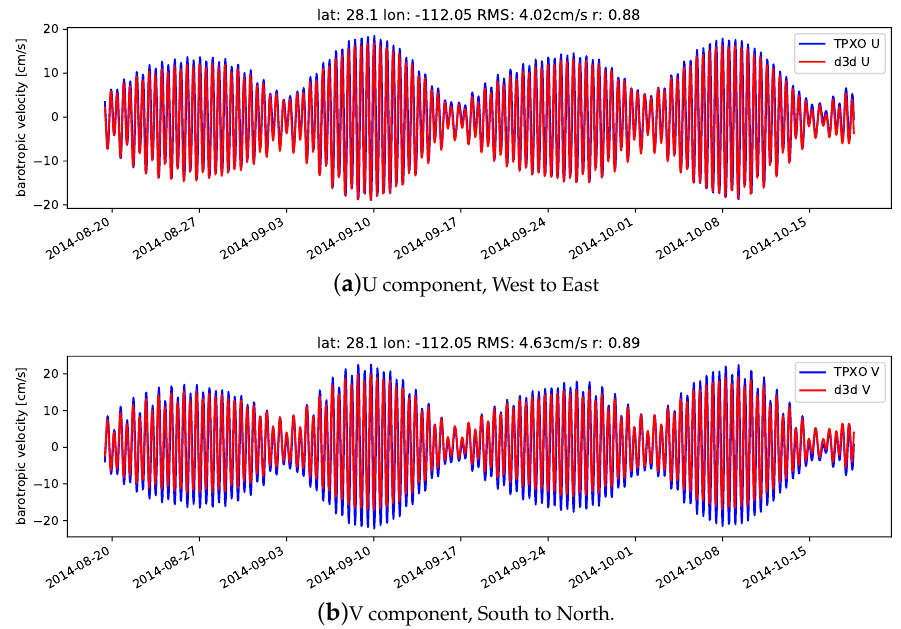
Figure 8. Time-series of components of the barotropic current at latitude 28.1 N, longitude—112.05 E. The delf3D (d3d) components have been depth-averaged for comparison. All dates in UTC.